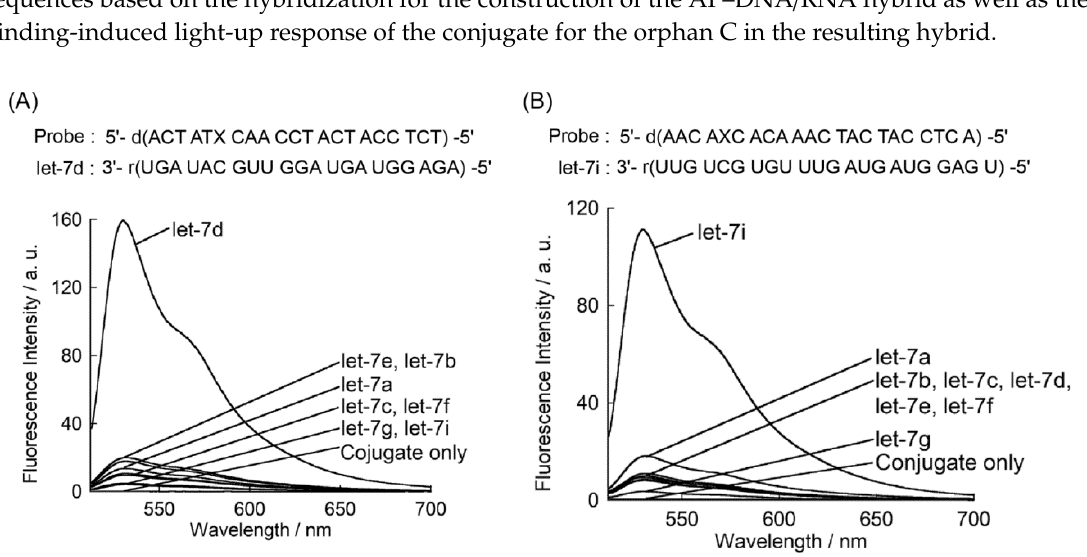
Figure S1: 1 H NMR spectra of the conjugates; Figure S2: ESI-MS spectra of the conjugates; Figure S3: Fluorescence response of ClNaph to target dSpacer-containing AP–DNA duplexes. Inset: Titration curves for the binding nucleobases; Figure S5: Fluorescence response of ClNaph unit in the conjugate to target AP–DNA duplexes. Figure S6: Chemical structure of ClNaph–TO2 conjugate and its fluorescence response to target AP–DNA duplexes; Figure S7: Titration curves of the binding of ClNaph–TO conjugate to target C in the AP–DNA / RNA hybrid and AP–RNA duplex; Table S1: Sequences of let-7 members used in this study. Figure S8. Titration curves for the binding of ClNaph–TO conjugate to the let-7d / DNA probe hybrid.